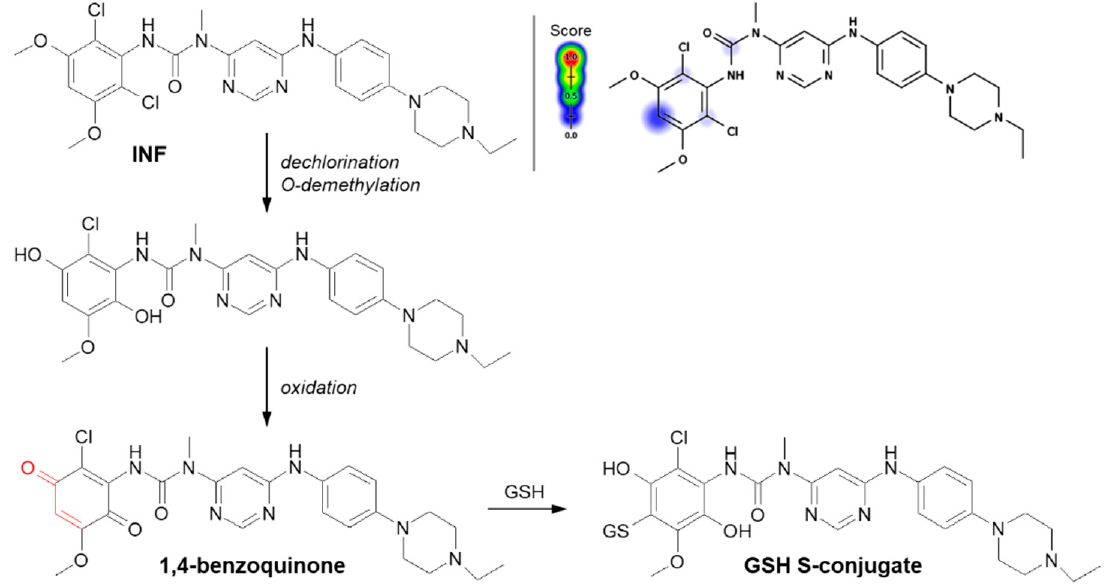
Figure 14. Reaction scheme of infigratinib (INF) conjugation with GSH [126]. A Michael acceptor moiety is marked in red. Predicted bioactive sites of GSH conjugation for anticancer drug were ob- tained by XenoSite Reactivity Predictor available at https://swami.wustl.edu/xenosite/p/reactivity (accessed on 18 May 2022).